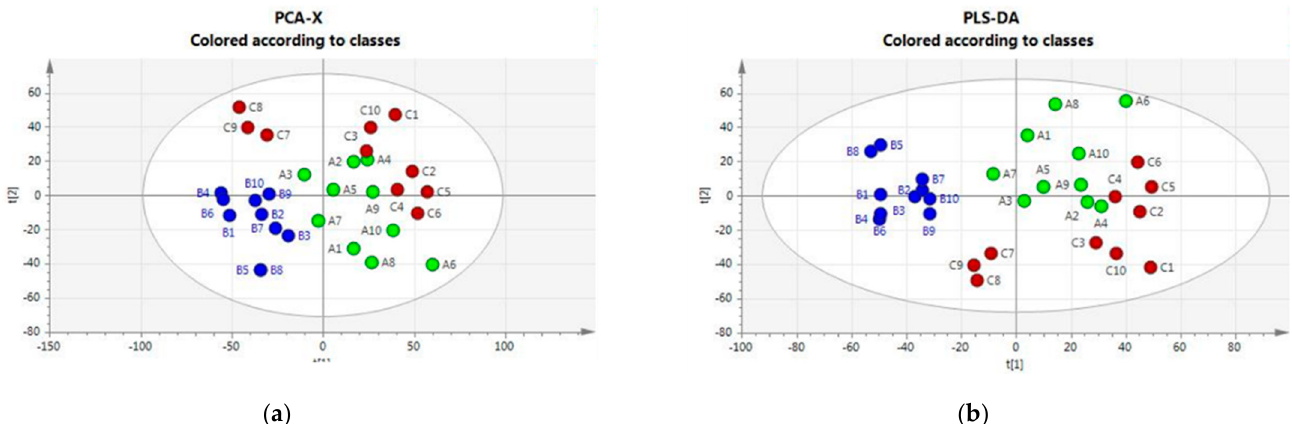
Figure 1. ( a ) PCA score plots and loading plots. Green class: Housing-A; Blu Class: Housing-B; Red class: Housing-C. ( b ) PLS-DA score plots and loading plots. Green class: Housing-A; Blu Class: Housing-B; Red class: Housing-C.